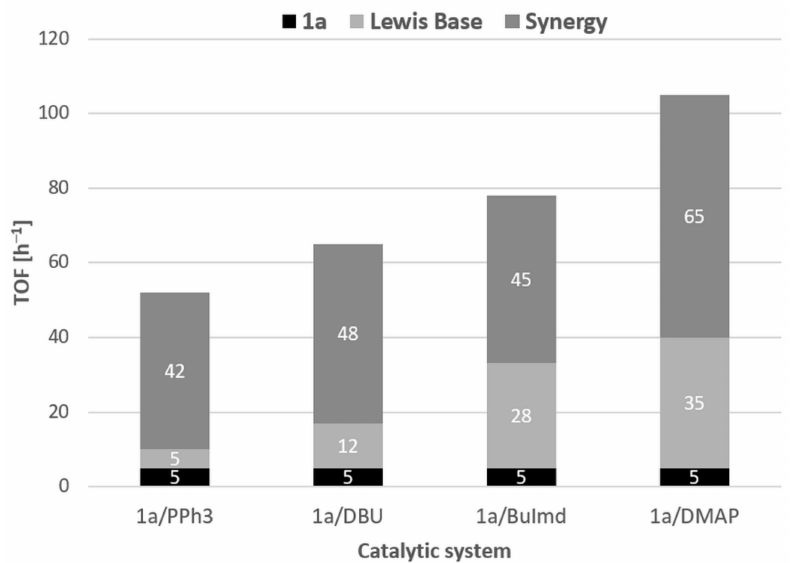
Figure 1. Synergistic effects found for different catalytic systems in the ROCOP of phthalic an- hydride and cyclohexene oxide (reaction conditions: 110 ◦ C, 2.5 mmol PA and 2.5 mmol CHO in 0.5 mL of toluene, reaction time of 60 min, and initial molar ratio [PA] 0 :[CHO] 0 :[ 1a ] 0 :[Lewis Base] 0 =